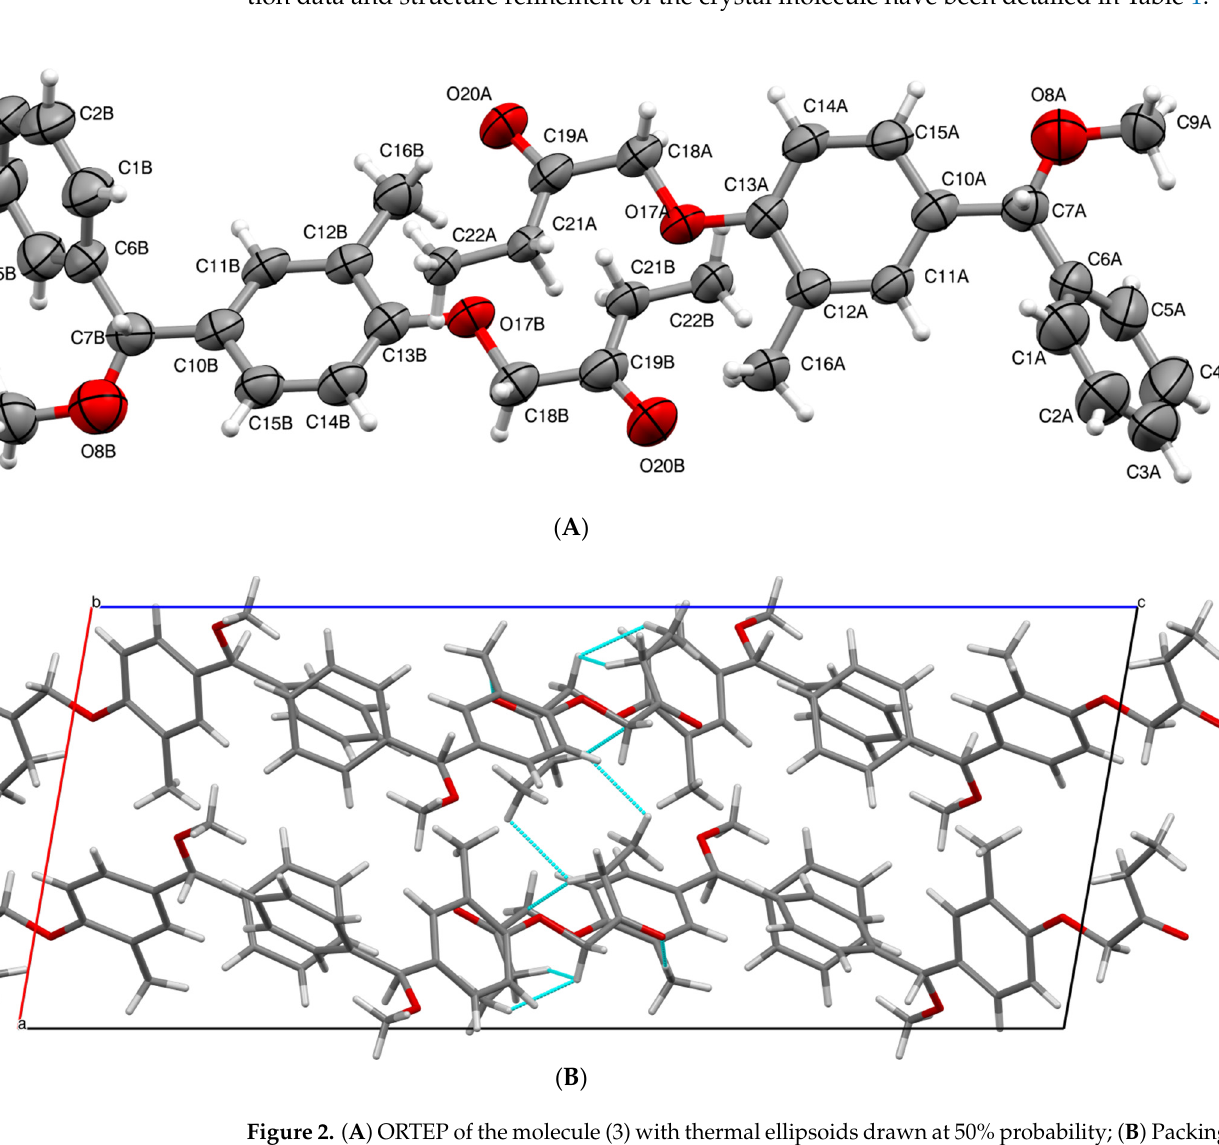
Figure 2. ( A ) ORTEP of the molecule (3) with thermal ellipsoids drawn at 50% probability; ( B ) Packing diagram of the molecule (3).